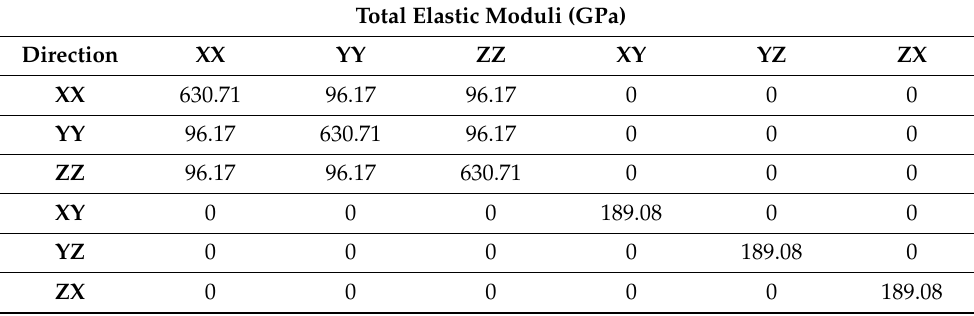
Table 3. Elastic moduli of TiN.